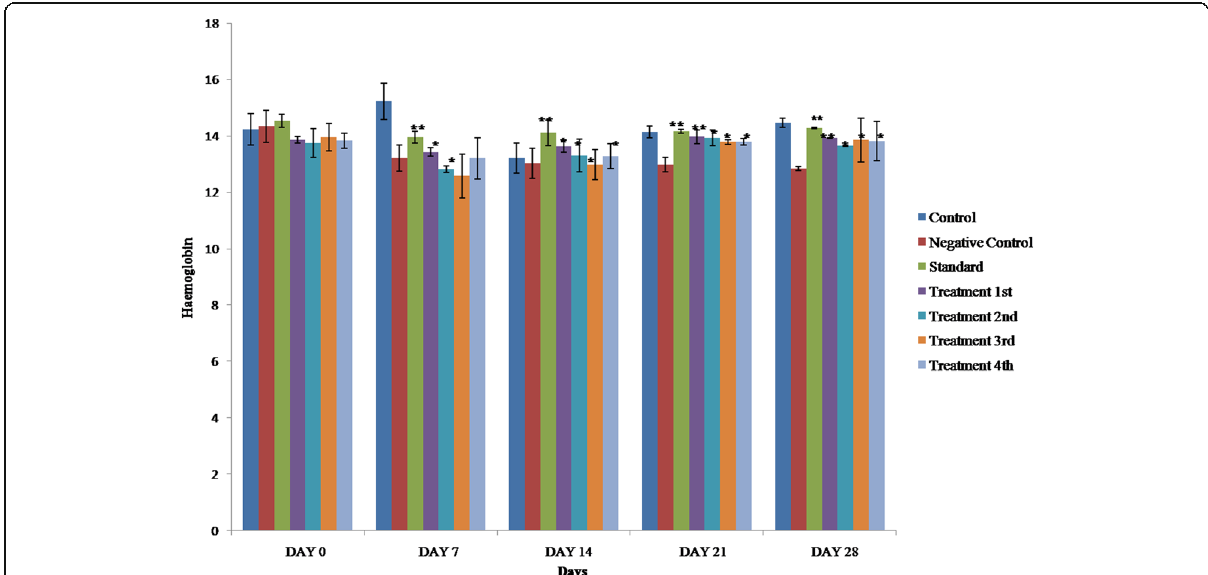
Fig. 7 Effect of PH extracts on hemoglobin content. Results are Mean ± S.E.M, n = 6 animals in each group. ANOVA, Dunnett ’ s test ** p < 0.001,* p < 0.05 compared with arthritic control group